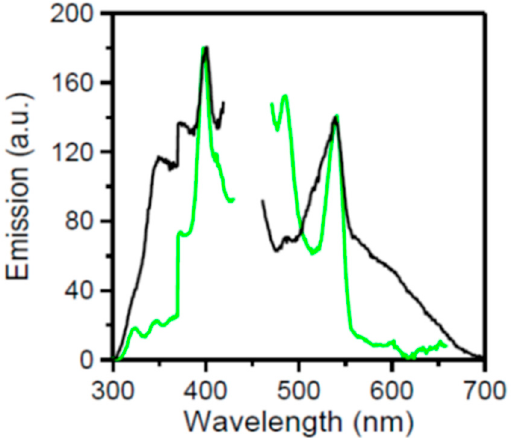
Figure 9. Solid-state, room-temperature excitation (left, emission, at 545) and emission (right, excitation at 397 nm) of mepaoH (black curves) and complex 4 (green curves).